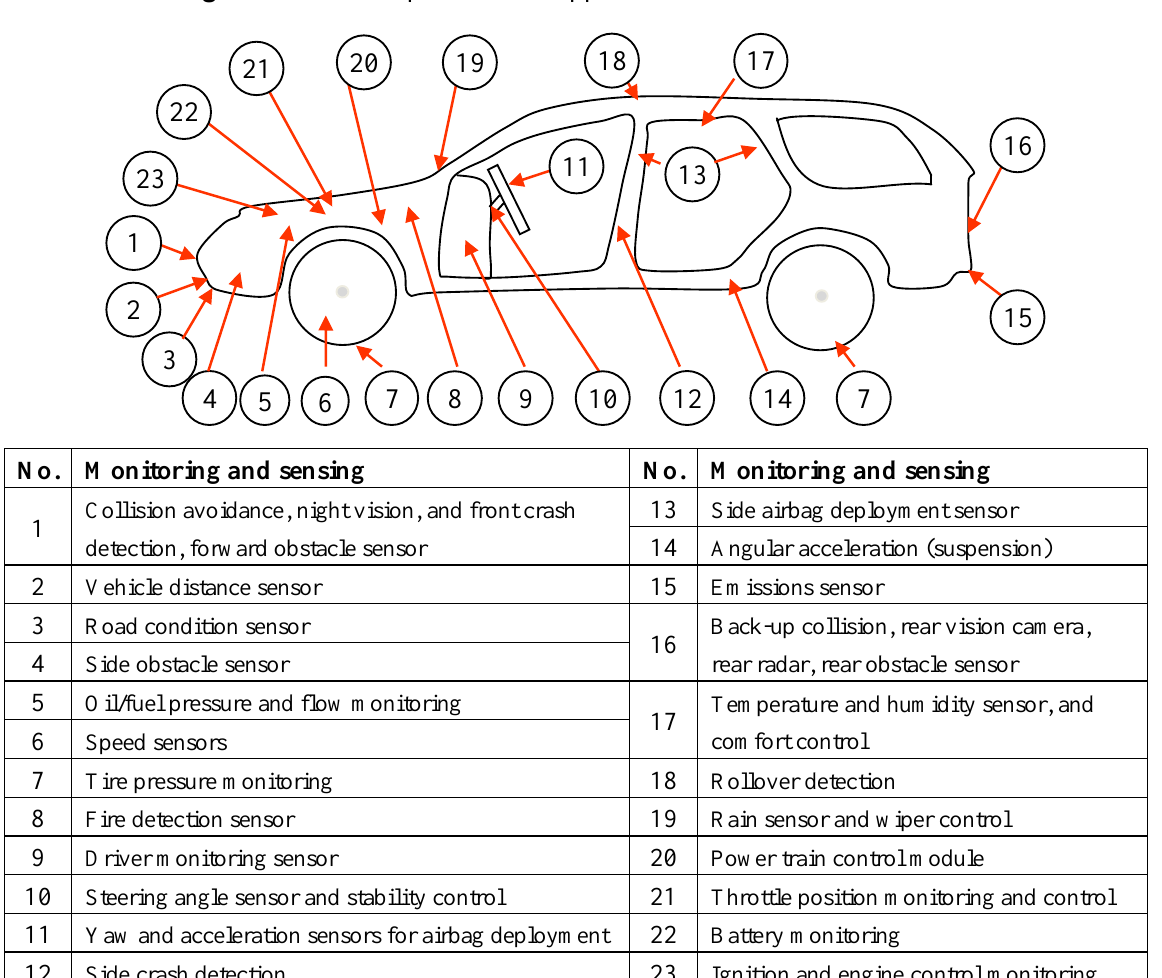
Figure 1. An example of PHM application for an automobile